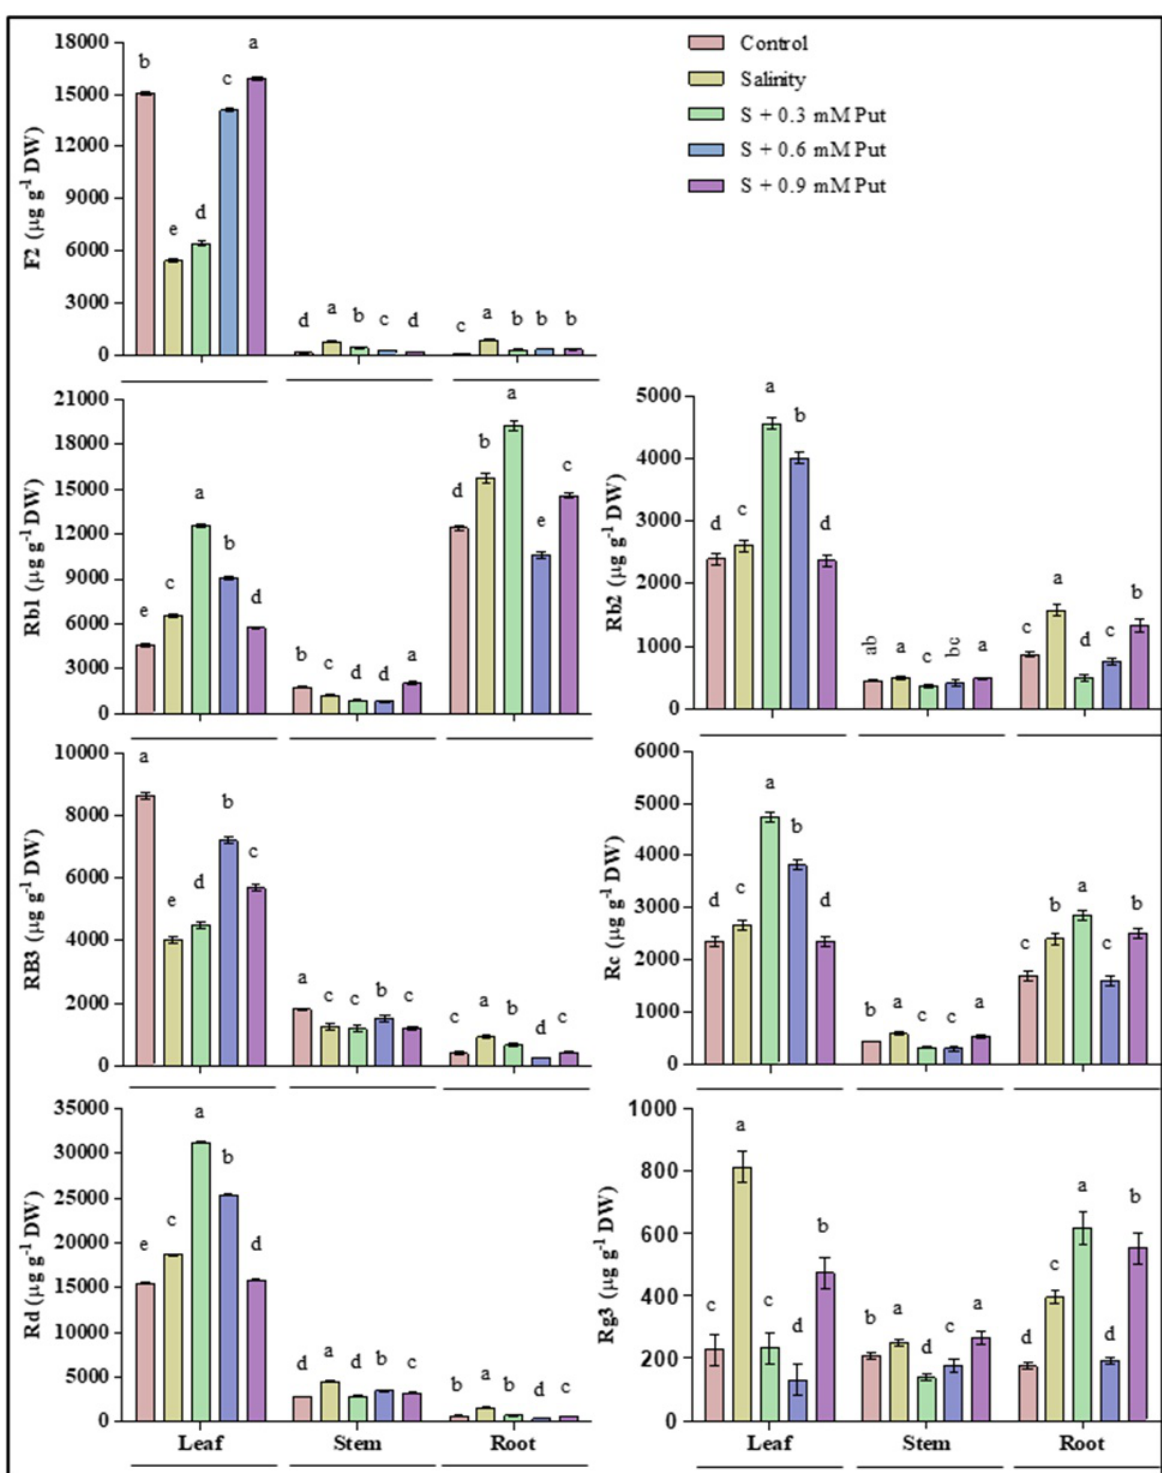
Figure 5. Effect of Putrescine on Ginsenosides (PPD type) in leaf, stem, and root of ginseng seedlings under salinity stress condition. Different letters indicate significant differences ( p ≤ 0.05) among the treatments within each parameter. Each value represents the mean ± SD ( n = 3).